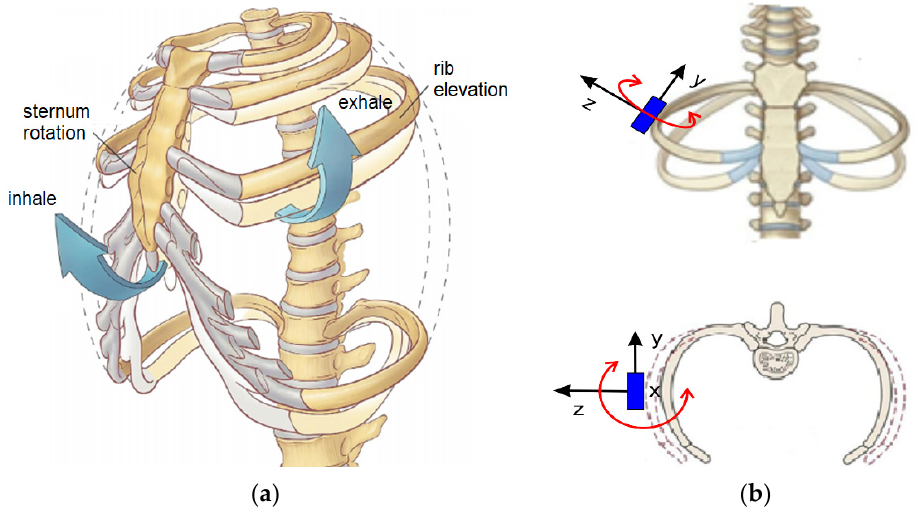
Figure 3. A scheme of the biomechanics of respiration: ( a ) the ribcage thorax motions; ( b ) sensed rib motions.